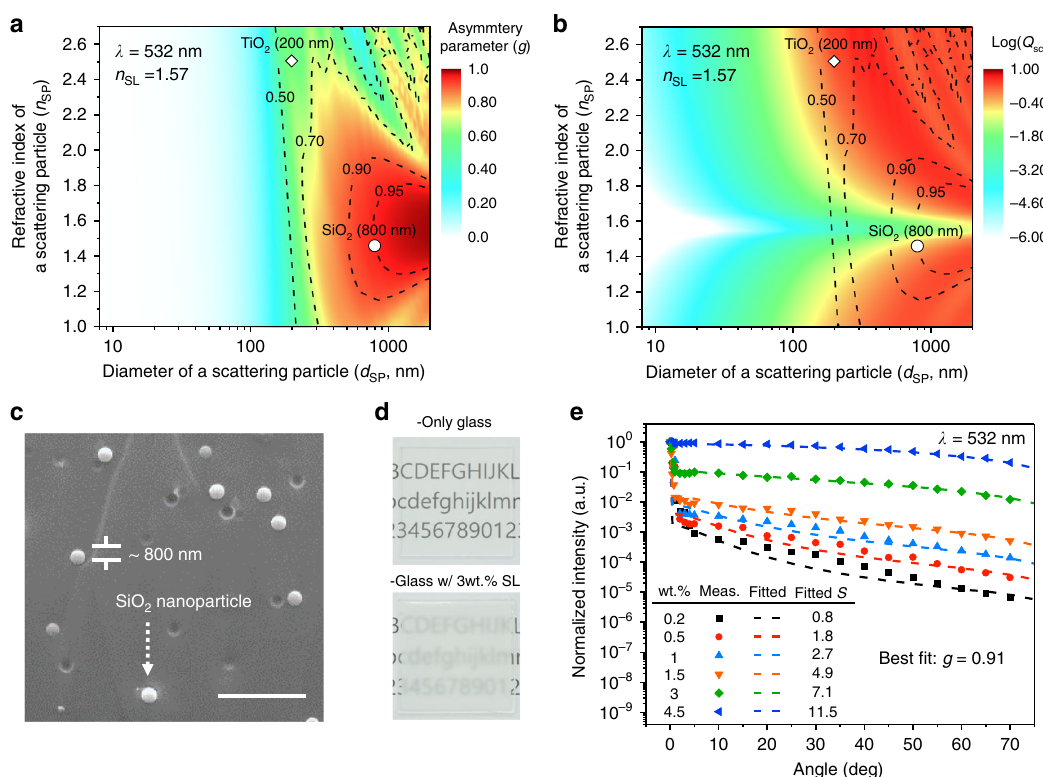
Fig. 2 Design and analysis of a scattering layer. a , b Calculated ( a ) asymmetry parameter ( g ) and (b) logarithm of the scattering ef fi ciency ( Q sc ) of a scattering layer at the wavelength ( λ ) of 532 nm according to the diameter ( d SP ) and refractive index ( n SP ) of a scattering particle (SP) in the host (NOA 73, n SL ∼ 1.57). c A scanning electron microscope image of a fabricated SiO 2 -based scattering layer (scale bar: 5 μ m). d Photographs of glass without a scattering layer and with a scattering layer (SL) fabricated using 3 wt.% solution. e Measured (dot) and fi tted (dashed) graphs of angular characteristic of scattered light after passing through SiO 2 embedded scattering layers. 532 nm-laser was used for the